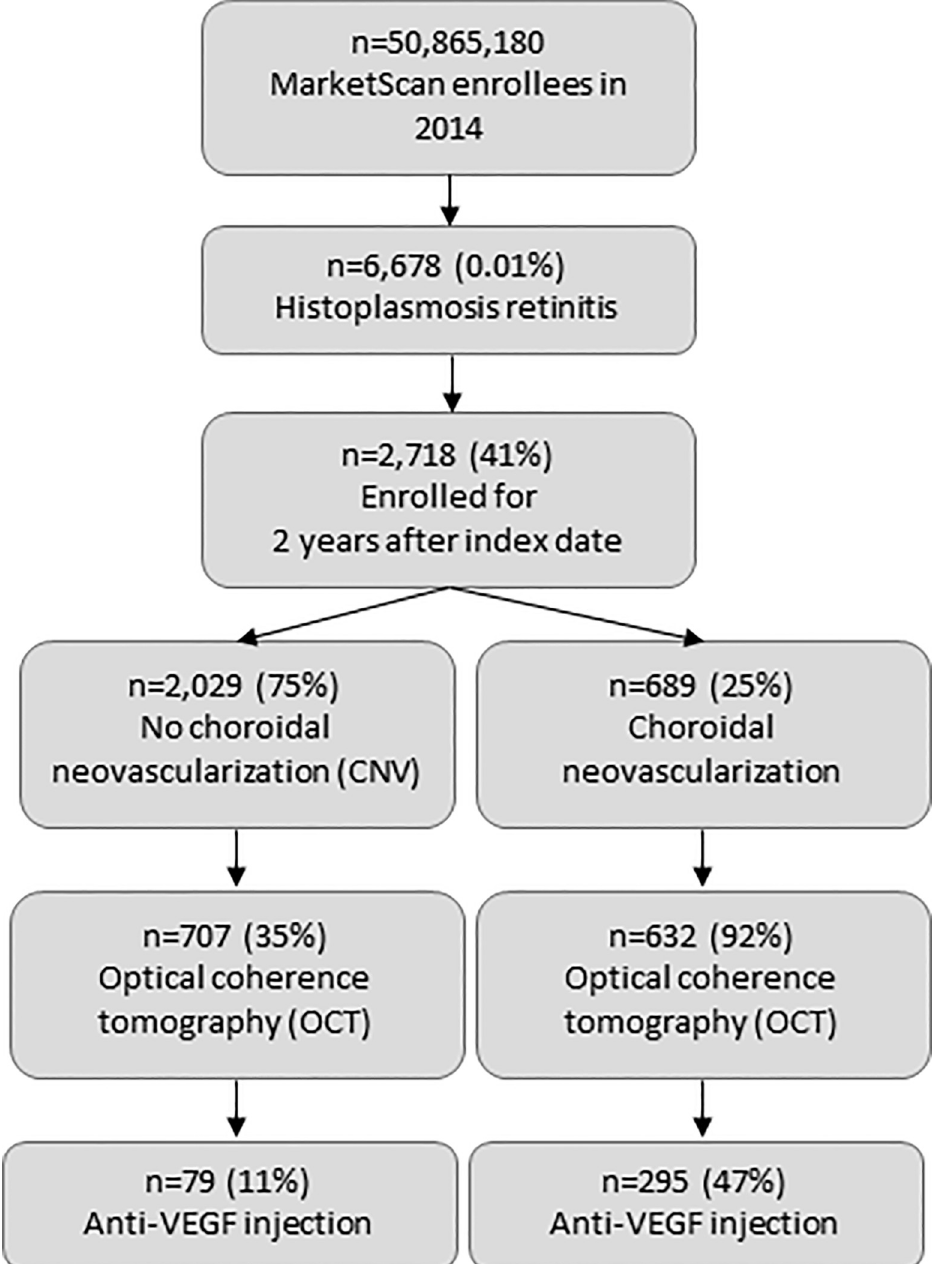
Fig 1. Enrollment and treatment, patients with presumed ocular histoplasmosis syndrome,